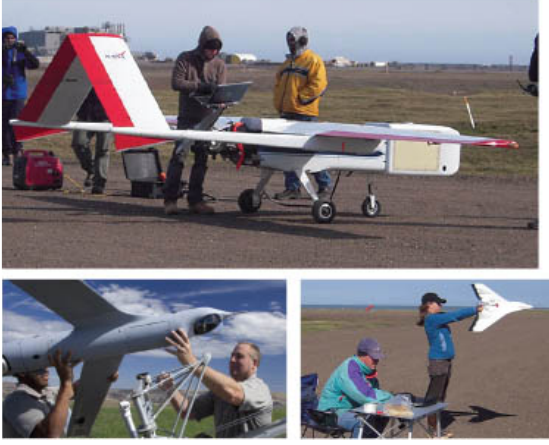
Figure 7. UAS used during MIZOPEX included SIERRA (top), ScanEagle (bottom left) and DataHawk (bottom right)